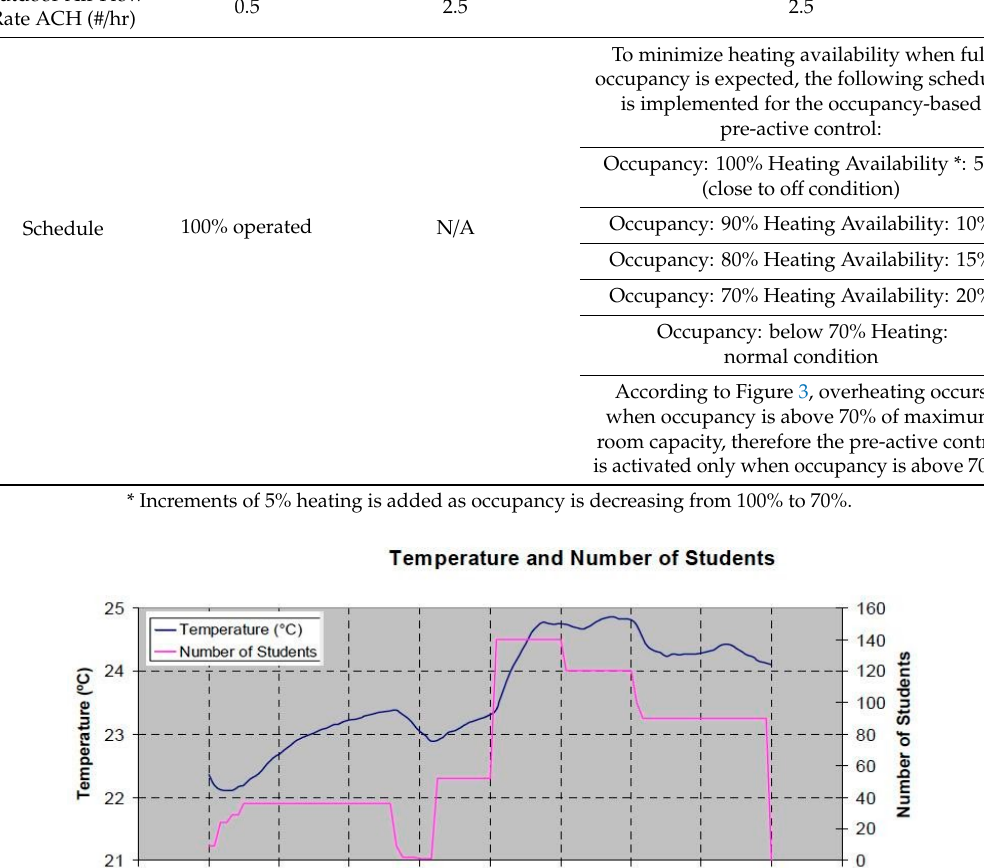
Figure 4. Increase in carbon dioxide due to the addition of occupants in the classroom.